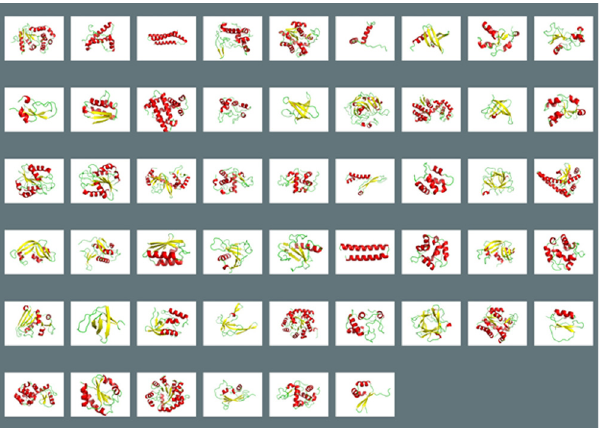
doi:10.1371/journal.pone.0138022.g004